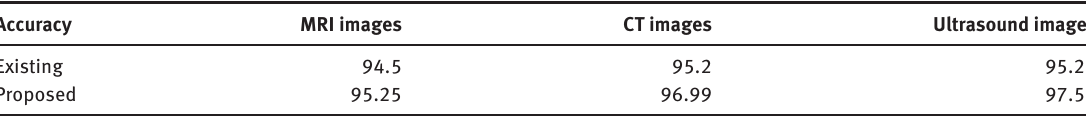
Table 3: Comparison of Proposed and Existing Accuracy